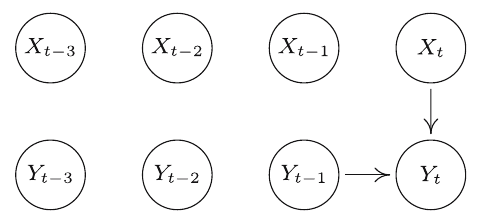
Figure A1: Interaction between two time series in which X t controls the mechanism relating Y t −1 and Y t , but all other observations are